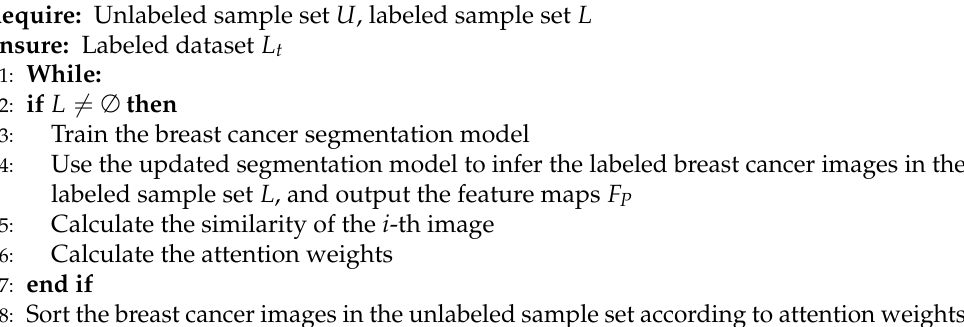
Algorithm 1 Labeling strategy of breast cancer samples based on active